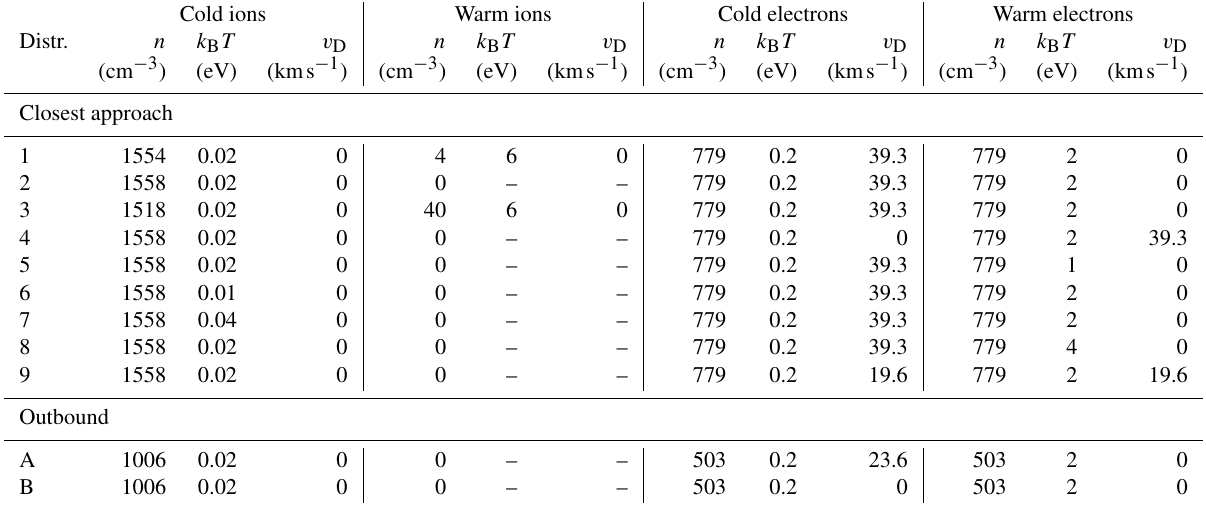
Table 1. Parameters of the distributions used in the examples related to the plasma at closest approach. In the table, n means density, k B is Boltzmann’s constant, T denotes temperature, and v D represents drift speed. Cold ions Warm ions Cold electrons Warm electrons Distr. Closest approach